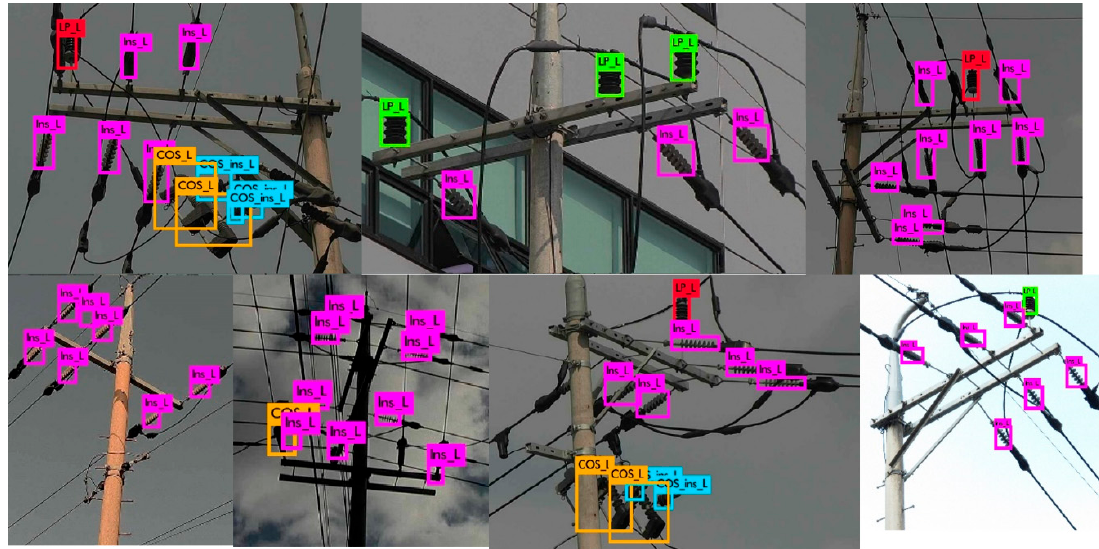
Figure 3. Detection results generated by our rotation invariant multi-type LR insulator detector in long-shot low-resolution images. (here symbols Ins_L, COS_L, COS_ins_L and LP represent polymer insulator, Cut-out-Switch, COS add-on and Line Post, respectively).